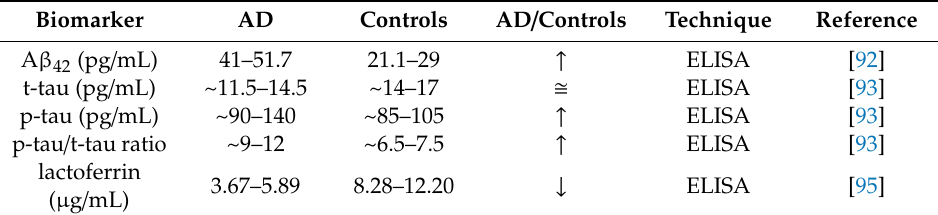
Table 3. Changes in levels of salivary biomarkers in AD patients and controls.